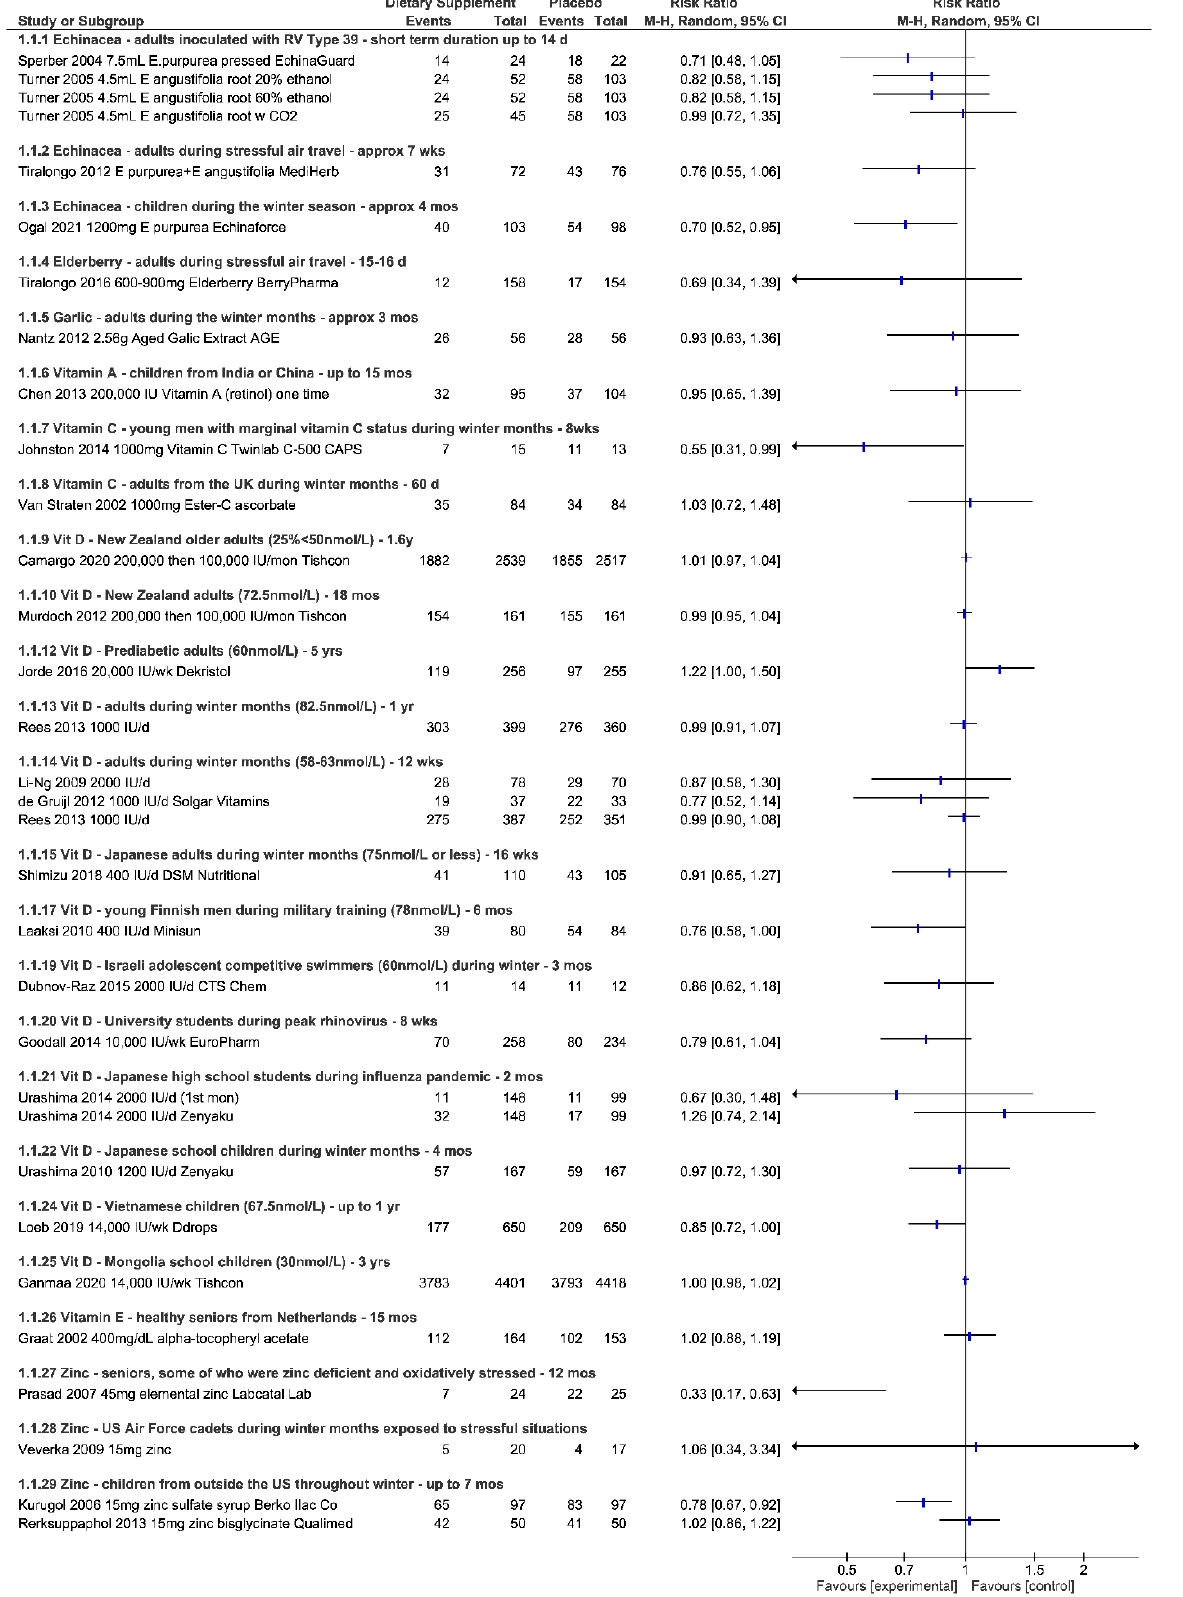
Figure 1. Analysis 1.1 Number of persons experiencing at least one infection.